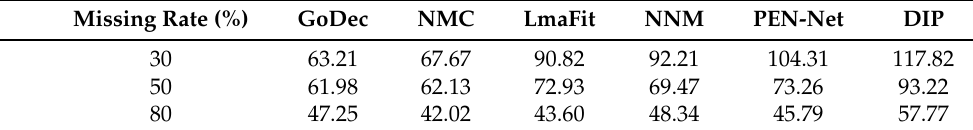
Table 2. PNSR comparison of data recovery methods for pixel-wise missing data.